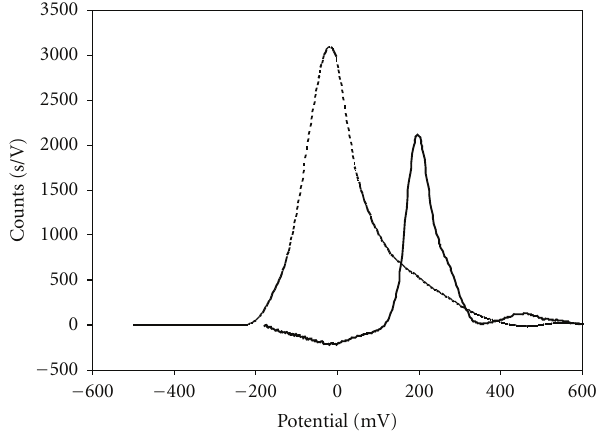
Figure 2: Background corrected chronopotentiometric signals obtained successively for As (full line) and Cd (broken line) by analysing a cadmium sulphate solution containing 100 µ g/L and 20g/L of As and Cd, respectively. See experimental parameters in Section 2. Table 3: Analytical figures of merit.